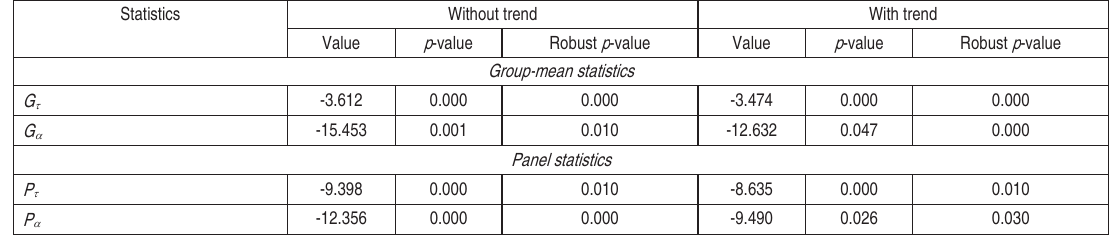
Table 2. Westerlund (2007) error-correction-based panel cointegration tests Statistics Without trend With trend Value p -value Robust p